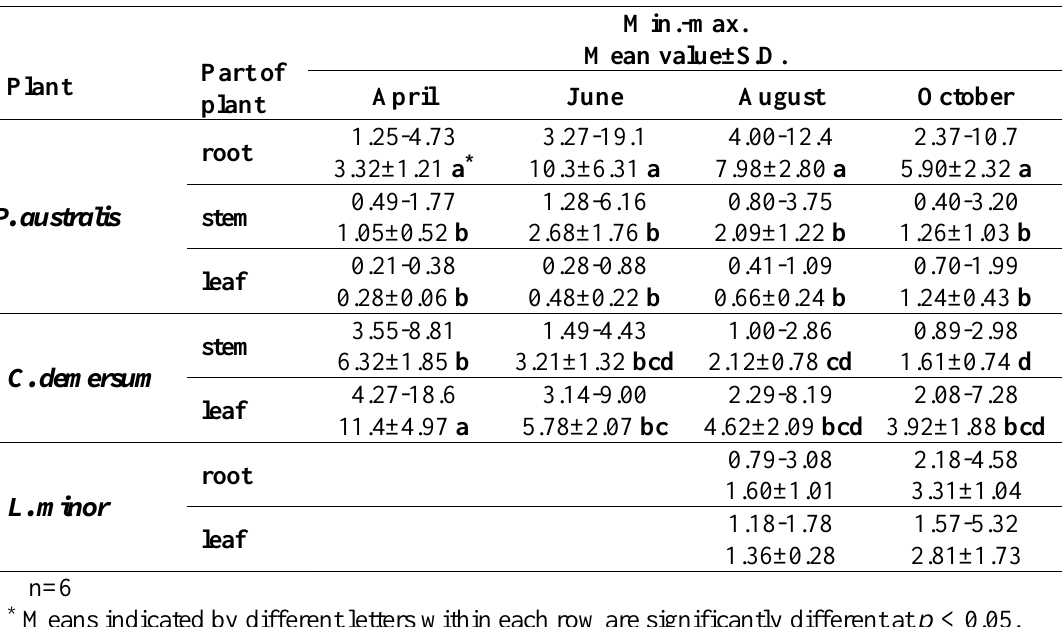
Table 4. Seasonal changes in concentrations of Cr (mg/kg of dry matter) in parts of investigated plants; minimum and maximum value and the mean value of concentration ± standard deviation Min.-max. Mean value±S.D. Part of Plant April June August October plant